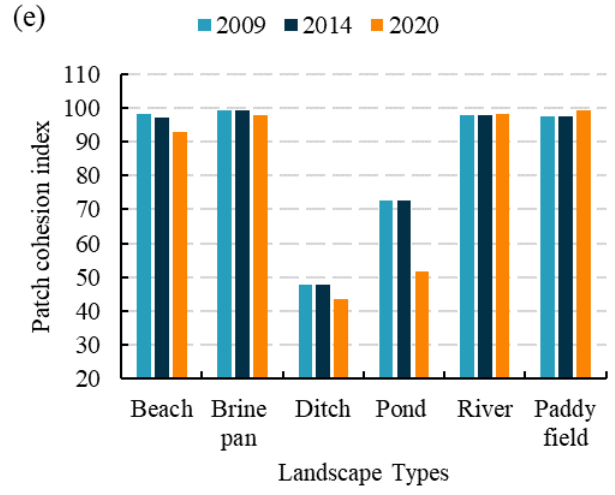
Figure 6. Landscape indices on the landscape class level in the study area from 2009 to 2020: ( a ) change in NP; ( b ) change in PD; ( c ) change in ED; ( d ) change in IJI; ( e ) change in COHESION.